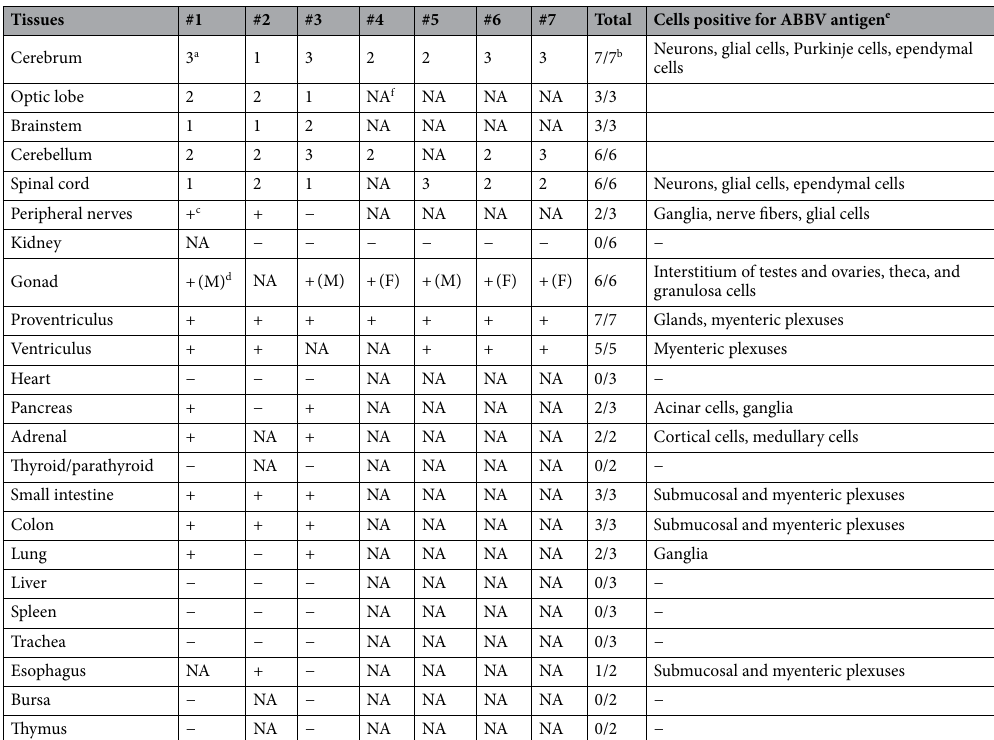
Table 4. Distribution of tissue reactivity for aquatic bird bornavirus N protein in seven ducks infected with ABBV-1 through the intracranial route 12 weeks post infection (wpi). a Indicates IHC distribution score for cerebrum, optic lobe, brainstem, cerebellum, and spinal cord. b Indicates the total number of birds with immunohistochemical reactivity in that tissue/total number of birds with available tissue for testing. c Indicates presence (+) or absence (−) of immunohistochemical reactivity in the tissue (without distribution score). d In parenthesis, male (M) or female (F) sex of the bird is indicated. e Description of the type of positive cells. f NA = tissue was not available for